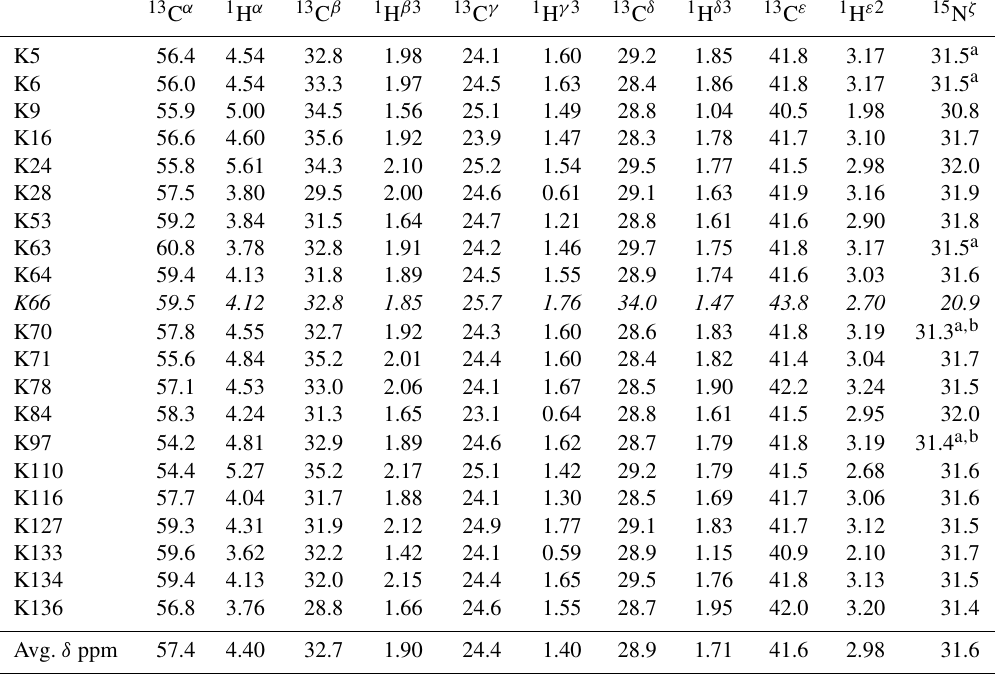
Table 1. The 1 H, 13 C, and 15 N chemical shifts for the side chains of the 21 Lys residues in (cid:49) + PHS/V66K SNase selectively labeled with SAIL-Lys in D 2 O. The 1 H and 13 C signals were assigned using the 3D HCCH TOCSY experiment recorded on a Bruker 600MHz spectrometer at 30 ◦ C, pH 8.0. The 15 N signals were assigned using a HECENZ experiment at 600MHz (see Fig. A4). The 1 H and 13 C chemical shifts were referenced to TSP, while the 15 N chemical shifts were referenced to DSS: δ DSS − δ TSP = 0.15ppm. Since one of the prochiral methylene protons was stereospecifically deuterated in the SAIL-Lys, i.e., [U- 13 C, 15 N; β 2 , γ 2 , δ 2 , ε 3 -D 4 ]-Lys, the observed 1 H signals were unambiguously assigned. The chemical shifts for the engineered Lys-66, which has a deprotonated ζ -amino group, are shown in italics. The averaged chemical shifts are obtained by excluding Lys-66, and the measurement errors were estimated as less than 0.05 and 0.01ppm, for the 13 C and 15 N and 1 H chemical shifts, respectively. All chemical shifts are not corrected for the isotope shifts. 13 C